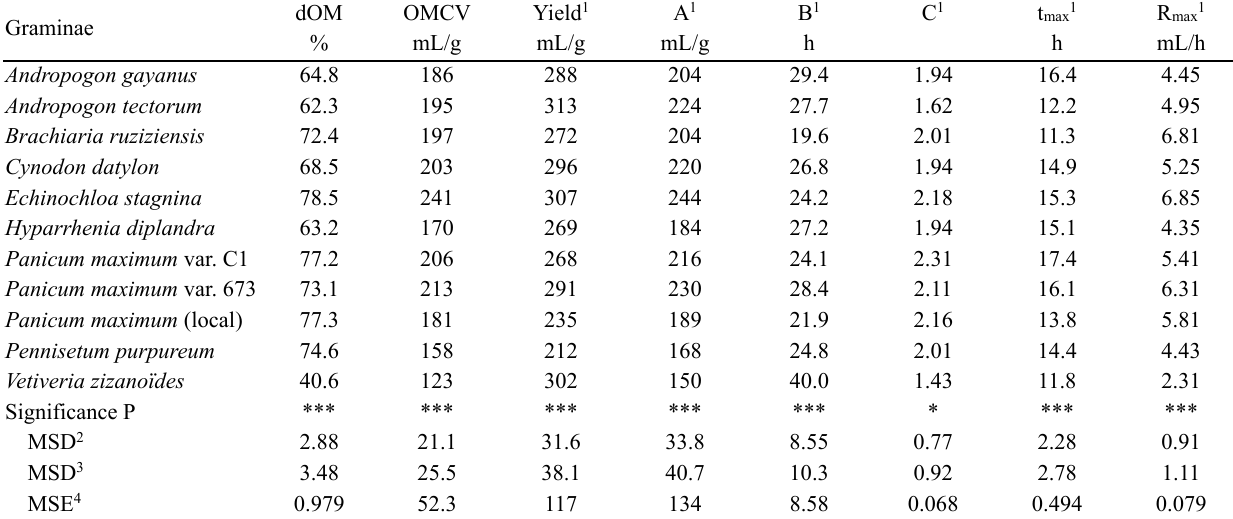
Table 3. In vitro fermentation characteristics of grasses dOM OMCV Yield 1 A 1 B 1 C 1 t max1 R max1 Graminae % mL/g mL/g mL/g h h mL/h Andropogon gayanus